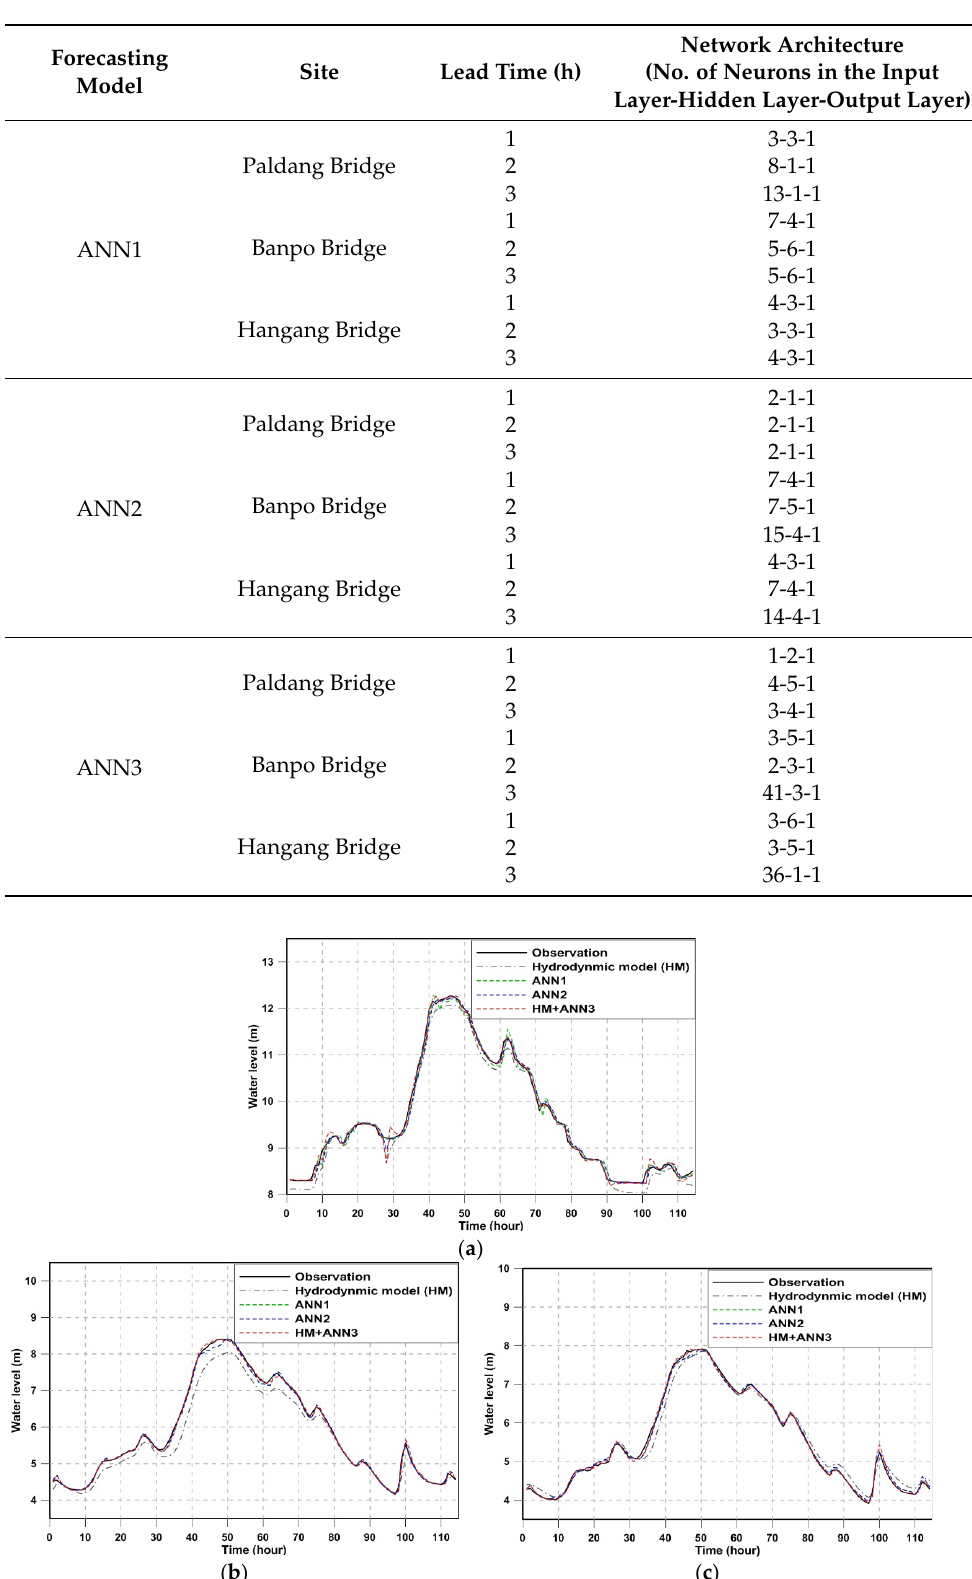
( c ) Figure 11. Two-hour lead time water levels calculated by various forecasting models for flood event 2 (15 July 2004–19 July 2004): ( a ) Paldang Bridge; ( b ) Banpo Bridge; ( c ) Hangang Bridge.